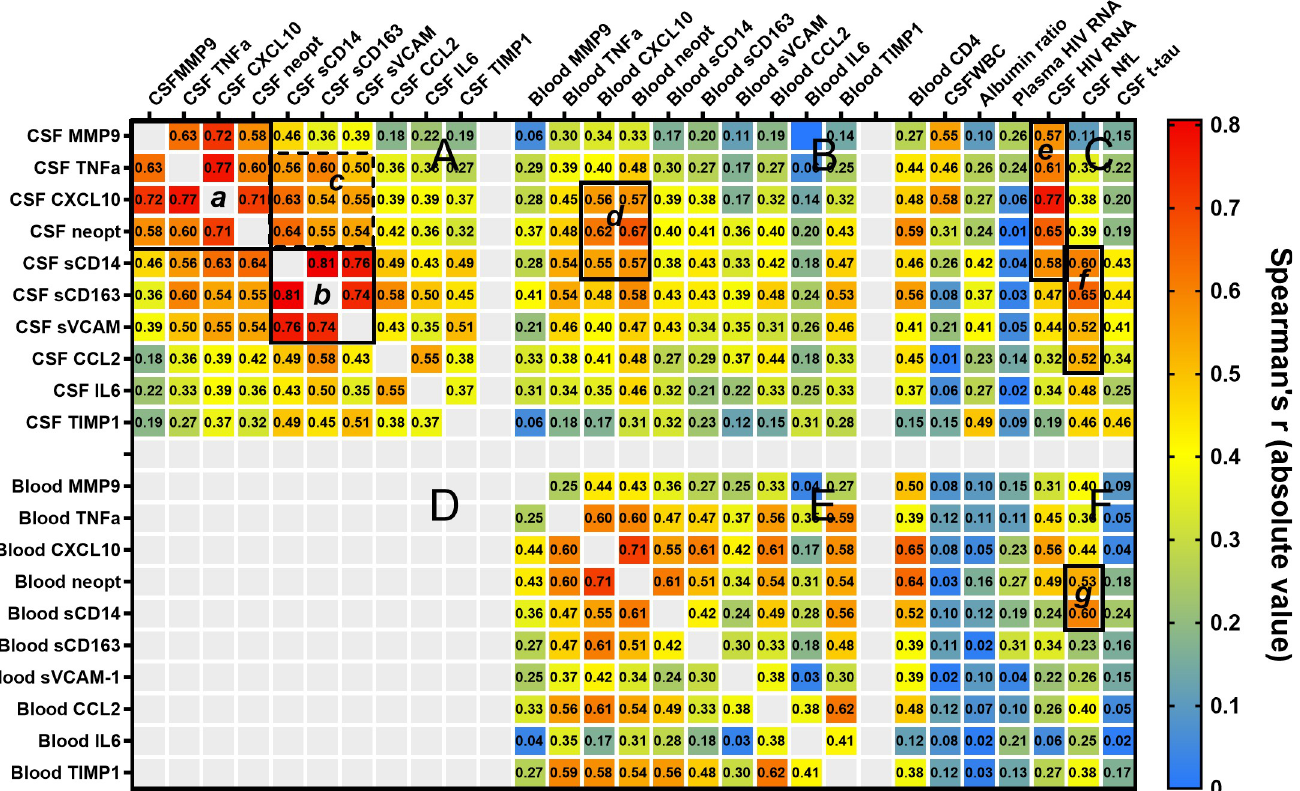
Fig 2. Correlations among the CSF and blood biomarkers and with selected background biomarkers. This blue-yellow-red heat map diagrams the Spearman’s correlation coefficient r across the entire data set expressed as absolute values and provides an overview of variable correlations. The absolute values are used to simplify comparison of positive and negative correlations, the latter involving blood CD4+ T cell counts and blood MMP9 concentrations which generally varied inversely with the other markers. The color scale provides a visual index while the r values are provided in each cell, mapping the relationships among the CSF and blood biomarker concentration across the entire sample. The large panels plot the Spearman’s r: among the CSF ( A ) and blood ( E ) inflammatory biomarkers; between the CSF and blood inflammatory biomarkers ( B); and between the CSF and blood inflammatory biomarkers and seven salient background biomarkers ( C and F ). Panel D is blank for visual simplicity since it would show the same matrix as B , flipped along a diagonal axis. The smaller outlined boxes ( a-g ) highlight some of the interesting biomarker relationships of interest as discussed in the